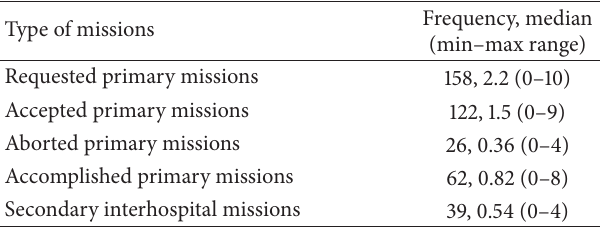
Table 2: Frequency and type of missions during the study’s